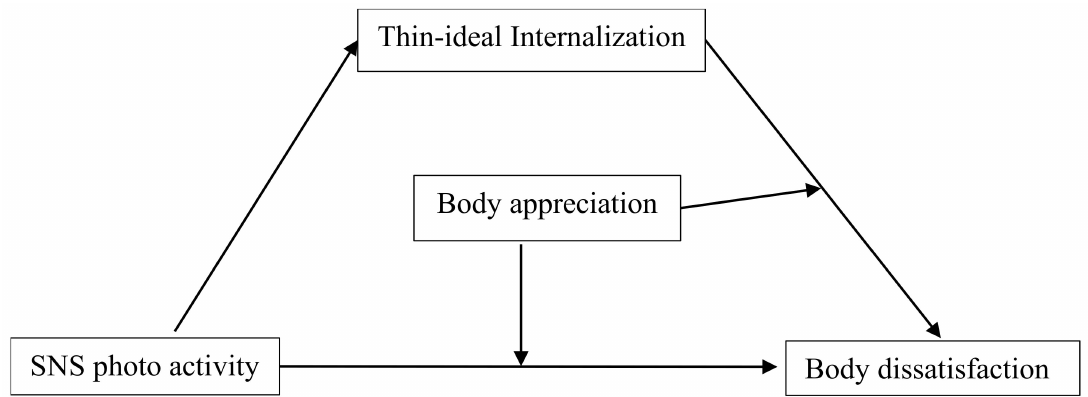
Figure 1. The proposed moderated mediation